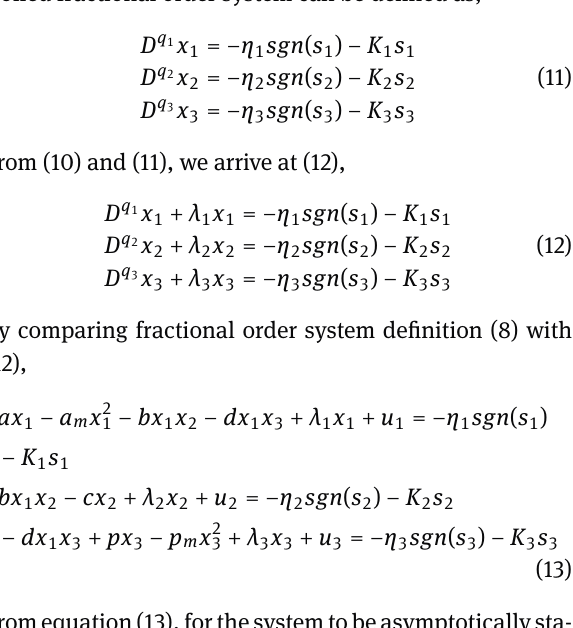
Fig. 2: 3D State portraits of the Fractional order WR